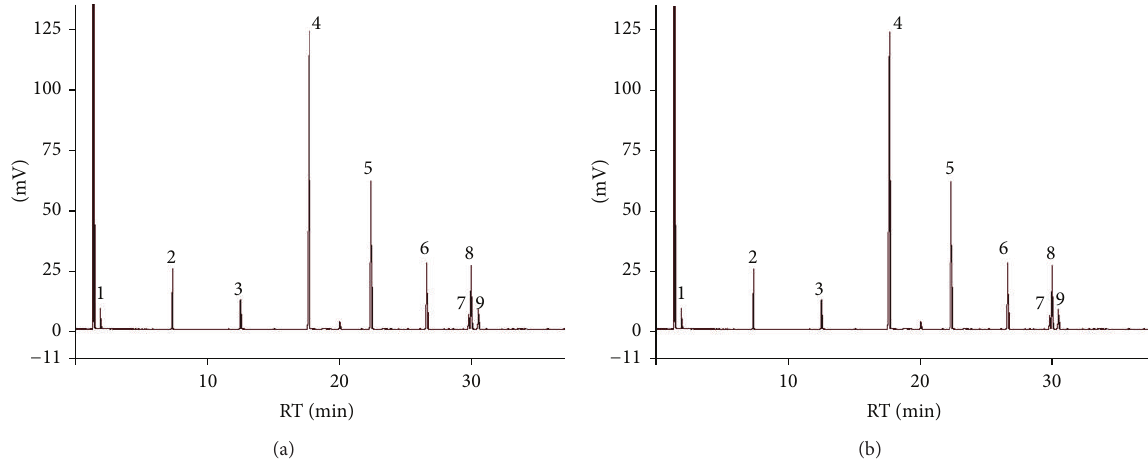
Figure 1: GC of FAME of (a) Soxhlet extracted oil from coconut copra, (b) commercial coconut oil. Peaks: (1) caproic acid (C 6:0 ), (2) caprylic acid (C 8:0 ), (3) capric acid (C 10:0 ), (4) lauric acid (C 12:0 ), (5) myristic acid (C 14:0 ), (6) palmitic acid (C 16:0 ), (7) linoleic acid (C 18:2 ), (8) oleic acid (C 18:1 ), (9) stearic acid (C 18:0